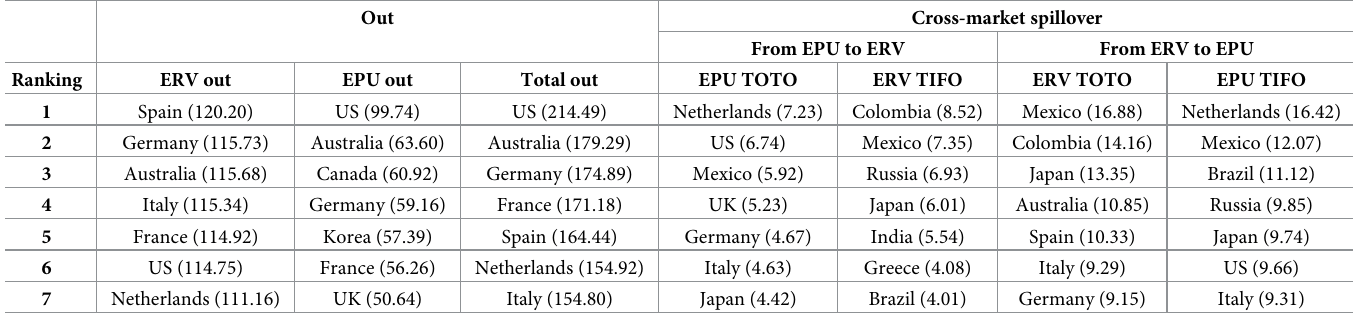
Table 2. Ranking of global systemically important